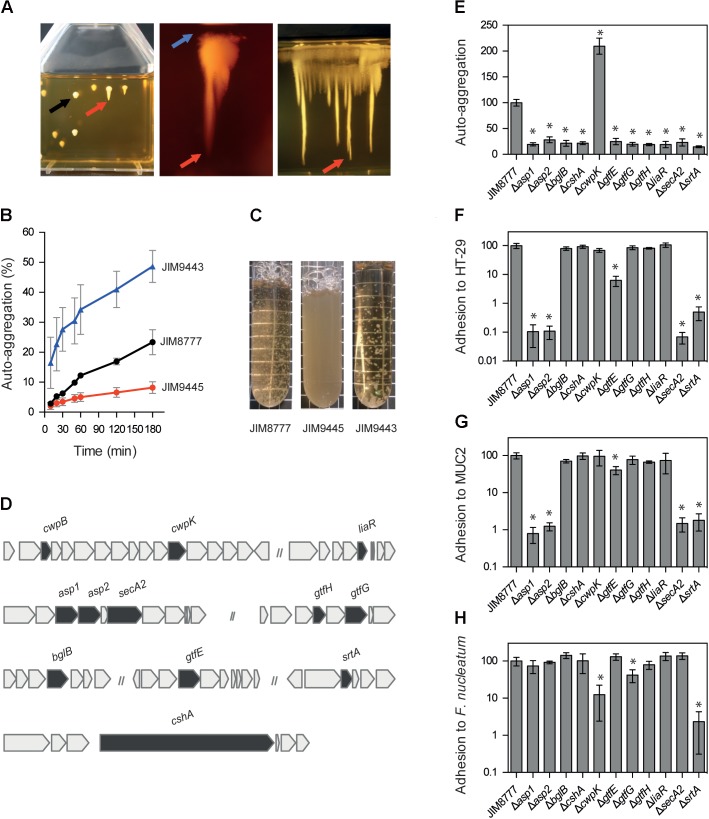
Identification of factors involved in S. salivarius JIM8777 auto-aggregation. (A) Growth of S. salivarius JIM8777 in semi-liquid (SL) agar medium (Left) and selection of spontaneous (Middle) and IS-induced (Right) mutants. Black arrow indicates round colonies formed by the auto-aggregating wild-type cells in SL conditions. Red and blue arrows indicate faster-sedimenting and slower-sedimenting mutants appearing as hanging down roots and as caps from round colonies, respectively. (B,C) Auto-aggregation abilities of the wild-type (JIM8777) and two spontaneous sedimenting mutants in liquid medium. Faster- (red, JIM9445) and slower-sedimenting (blue, JIM9443) mutants in SL agar medium correspond to non- and hyper-auto-aggregation mutants in liquid medium, respectively. (D) Organization of the genes involved in auto-aggregation. Mutated genes are in gray. The lengths of the genes and intergenic regions are drawn to scale. (E) Auto-aggregation and adhesion of the wild-type JIM8777 and reconstructed auto-aggregation mutants to the (F) HT-29 epithelial cell line, (G) MUC2 glycoprotein and (H)
Fusobacterium nucleatum. Means and standard deviation values correspond to at least three independent experiments done in duplicate. Results were normalized against those of JIM8777. Asterisks indicate statistical significance (Student’s unpaired t-test: ∗P < 0.005).